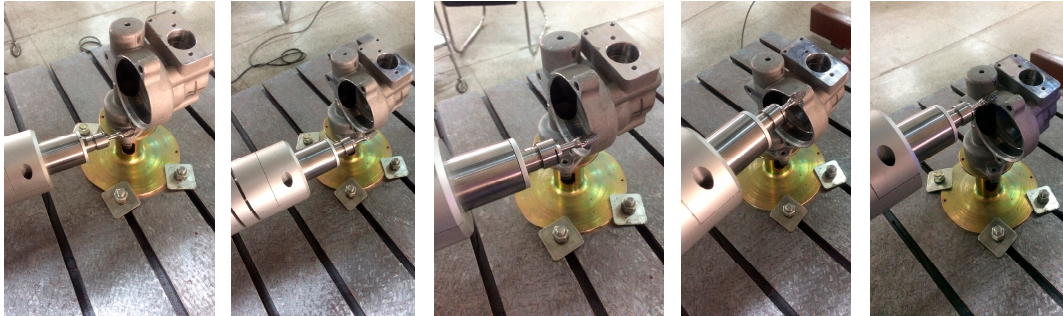
Figure 27. Experimental deburring of facet edges on proximal side facet.